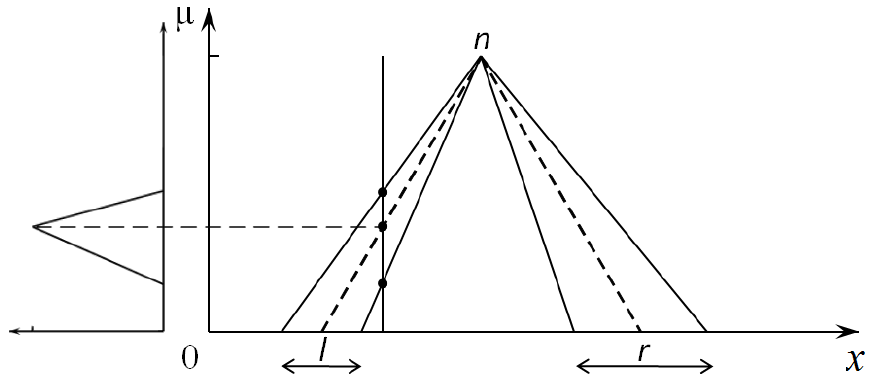
Figure 2. A type-2 fuzzy set corresponding to the situation depicted by Figure